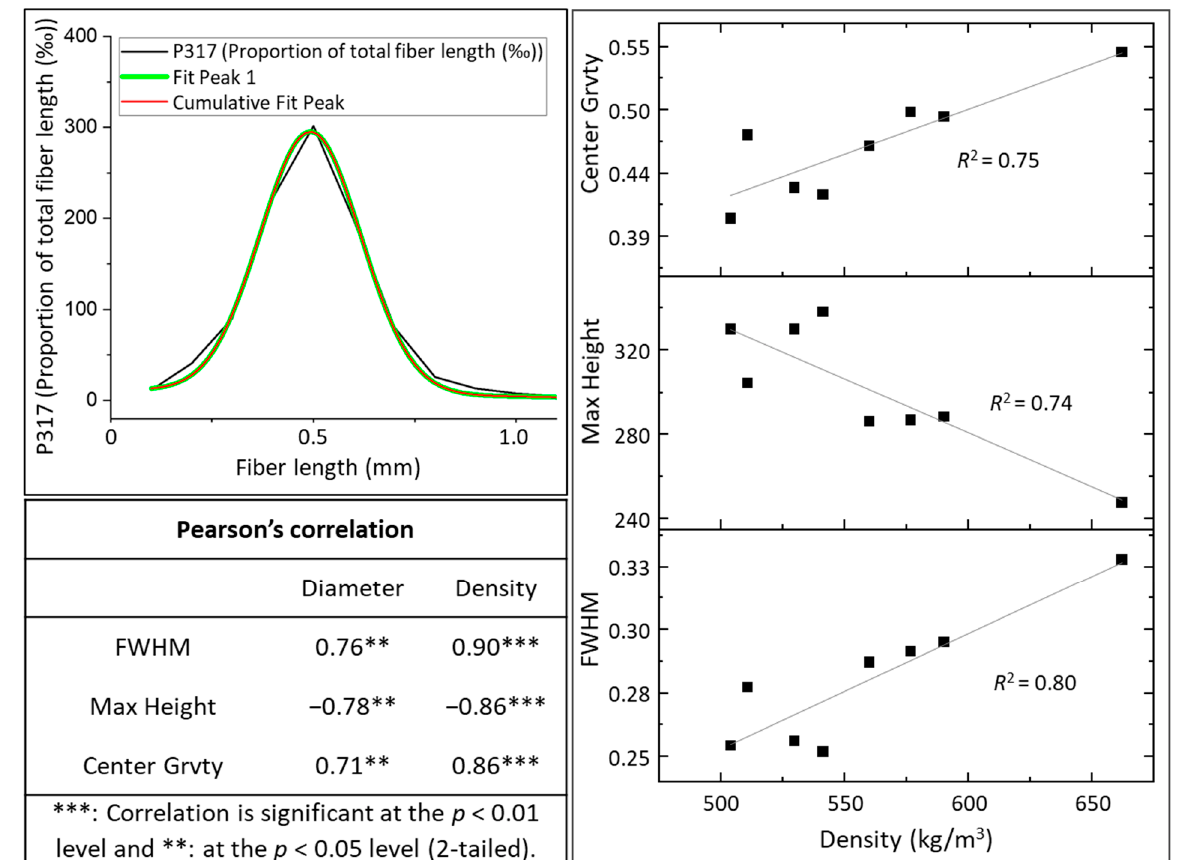
Figure 5. Statistical results of S. viminalis clone fiber analysis. 685 1 : clone from block 1.